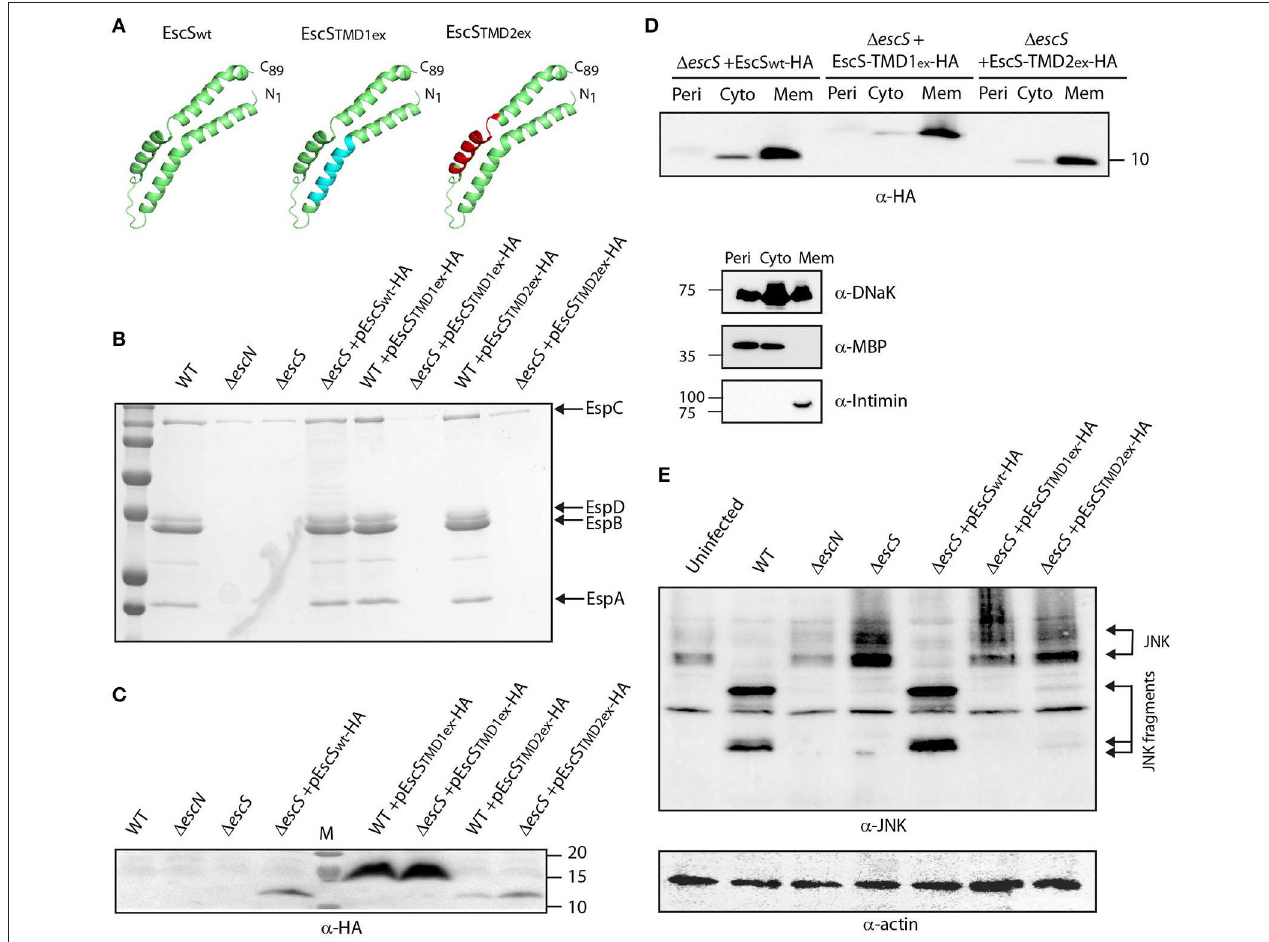
FIGURE 5 | Replacement of EscS TMDs by an alternative hydrophobic sequence abolishes T3SS activity. (A) 3D structure of EscS wt monomeric subunit within the EscR 5 S 4 T complex (green). The hydrophobic regions, TMD1 ex and TMD2 ex , that were replaced to 7L9A are marked in cyan and red, respectively. (B) Protein secretion profiles of EPEC WT, 1 escN , 1 escS , and 1 escS or WT strains carrying the pEscS wt -HA, pEscS-TMD1 ex -HA or pEscS-TMD2 ex -HA plasmids grown under T3SS-inducing conditions. The secreted fractions were concentrated and analyzed by SDS-PAGE and Coomassie staining. The secreted translocator EspA, EspB, and EspD are marked on the right of the gel. Also, indicated is the location of EspC, which is not secreted via the T3SS. The 1 escS strain carrying the plasmid encoding EscS wt -HA showed proper T3SS activity while replacement of either TMD1 or TMD2 to an alternative hydrophobic sequence resulted in non-functional T3SS. Expression of pEscS-TMD1 ex -HA or pEscS-TMD2 ex -HA within the WT EPEC strain had no dominant-negative effect on the T3SS activity. (C) EscS wt -HA, EscS-TMD1 ex -HA and EscS-TMD2 ex -HA expression was confirmed in the bacterial pellets obtained in (B) by SDS-PAGE and western blot analysis with an anti-HA antibody. EscS-TMD1 ex -HA migrated slightly slower than EscS wt -HA and EscS-TMD2 ex -HA. (D) EPEC 1 escS carrying either pEscS wt -HA, pEscS-TMD1 ex -HA, or pEscS-TMD2 ex -HA, were grown under T3SS-inducing conditions, fractionated into periplasmic (Peri), cytoplasmic (Cyto), and membrane (Mem) fractions and analyzed by western blot analysis with an anti-HA antibody. To confirm correct bacterial fractionation, the western blots were probed with anti-DnaK (cytoplasmic marker), anti-MBP (periplasmic marker), and anti-intimin (membrane marker) antibodies. (E) Proteins extracted from of HeLa cells infected with WT, 1 escN, 1 escS, or 1 escS carrying the pEscS wt -HA, pEscS-TMD1 ex -HA or pEscS-TMD2 ex -HA, were subjected to western blot analysis using anti-JNK antibody and anti-actin (loading control). JNK and its degradation fragments are indicated. WT EPEC showed massive degradation of JNK relative to the uninfected sample and the samples infected with 1 escN or 1 escS mutant strains. EPEC 1 escS complemented with pEscS wt -HA showed a JNK degradation profile similar to that of WT EPEC, indicating